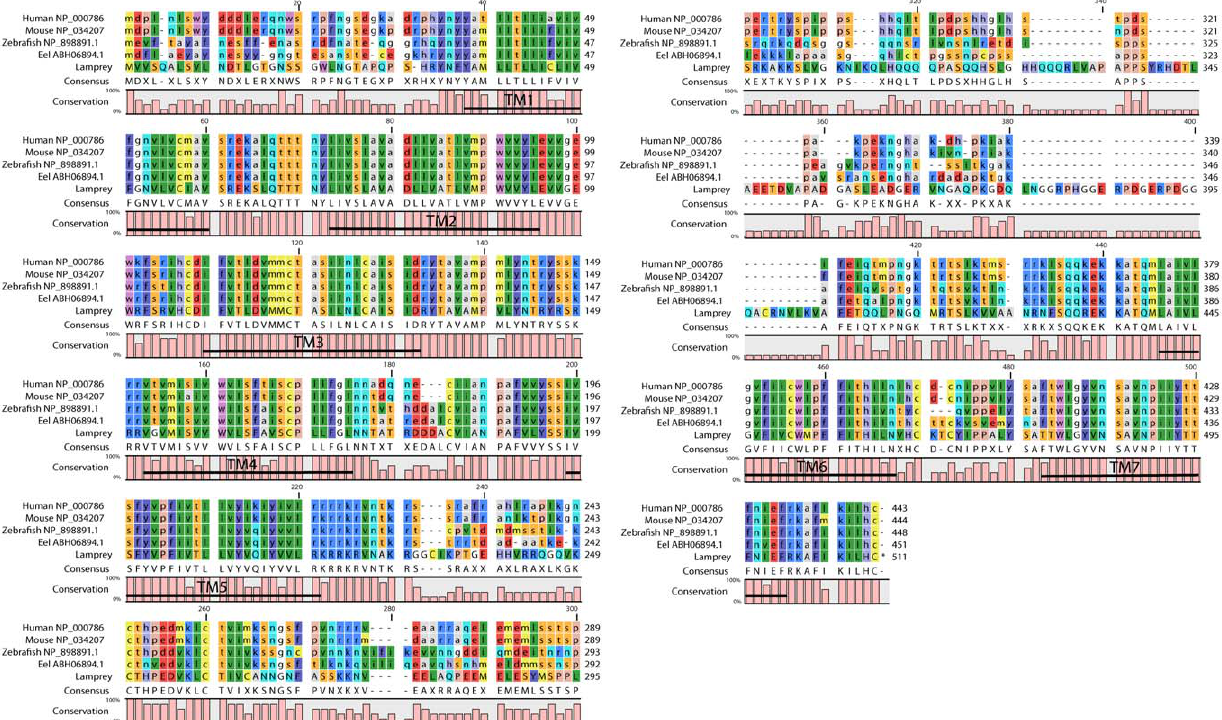
Figure 2. Alignment of dopamine D2 receptor amino acid sequences. Alignment of the deduced amino acid sequence from the lamprey dopamine D2 receptor with those from Homo sapiens , Mus musculus , Danio rerio and Anguilla anguilla . The seven transmembrane domains are indicated.